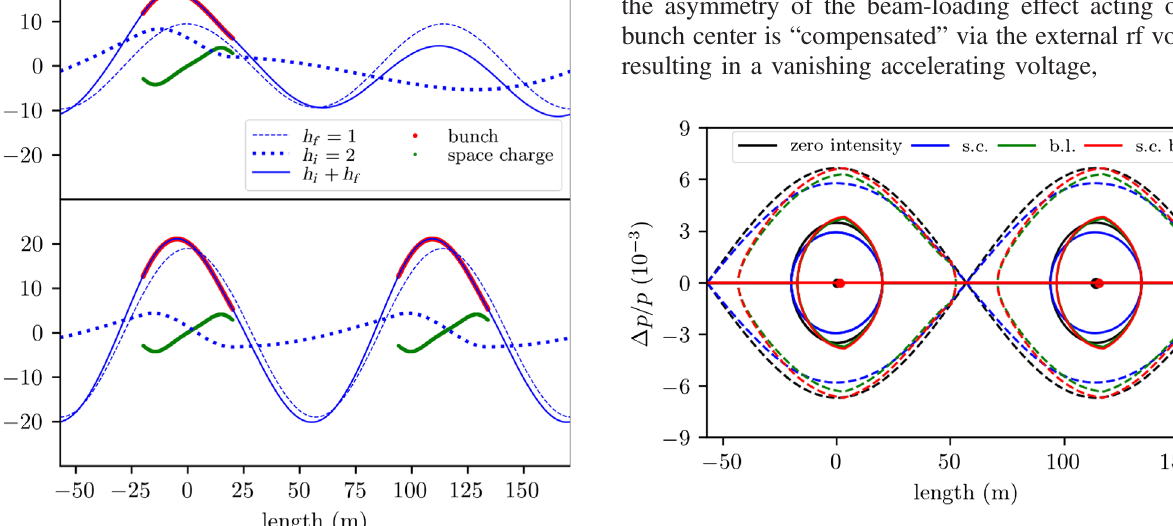
FIG. 5. The beam-loading voltages (solid blue) induced by one bunch (upper plot) and two bunches (lower plot) in the dual harmonic rf system of CSNS-II/RCS, compared with the space- charge voltages (green). The dotted and dashed blue lines represent the beam-loading voltages (wakefields) from h ¼ 2 harmonic systems, respectively. The red lines denote and h i the beam-loading voltages acting on the bunches.